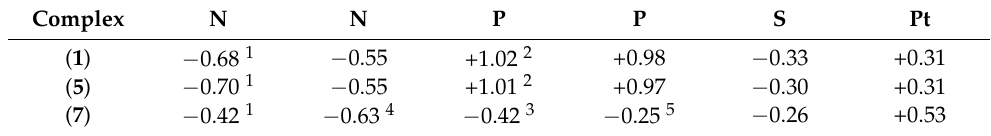
Table 6. NBO Charges for the selective complexes ( 1 , 5 , and 7